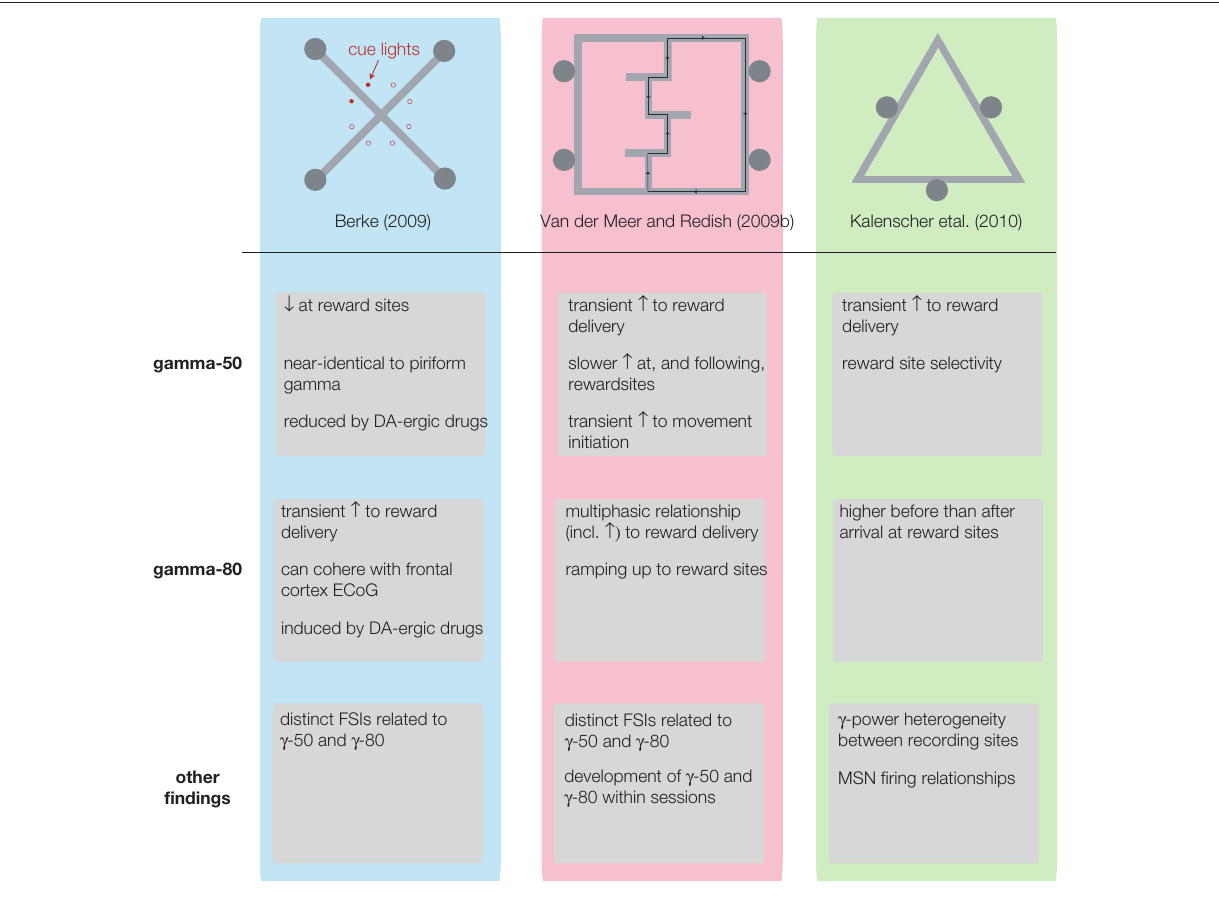
Figure 4 | Schematic representation of the tasks used (top) in Berke (2009, left), van der Meer and redish (2009b, middle), and Kalenscher et al. (2010, right), and summary of the main findings in each (bottom). In each study, rats ran to obtain appetitive rewards at reward sites (filled circles). In Berke (2009) the rewarded arm was indicated by cue lights visible from the central choice point. In van der Meer and Redish (2009b) only one side of the maze was rewarded, but the rewarded side was changed between recording sessions. In